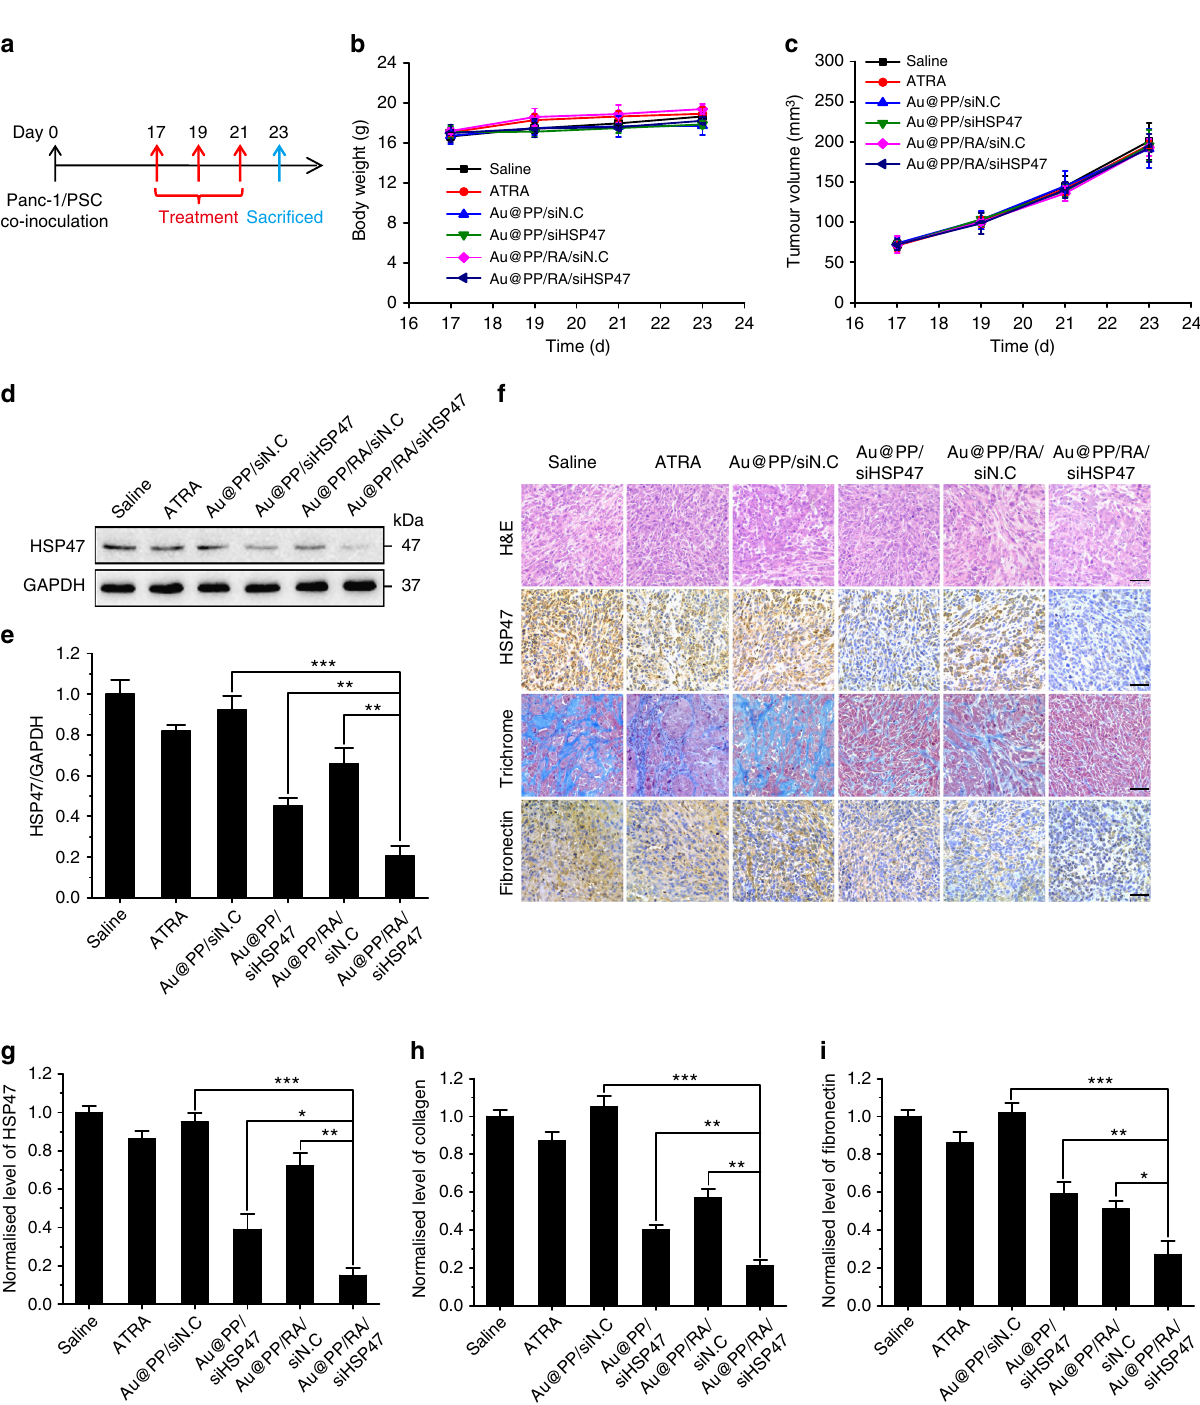
Fig. 7 Stroma modulation in Panc-1/PSC subcutaneous xenografts. a Scheme of different treatment formulations for stroma modulation. The desmoplastic pancreatic subcutaneous xenografts were established by co-inoculation of Panc-1 and PSCs in BALB/c nude mice. Various formulations (ATRA: 2.4 mg/kg; siRNA: 0.97 mg/kg) were given intravenously every 2 days for three injections. b Body weight changes of mice during treatment. c Tumour growth curves during treatment. d Western blot analysis of HSP47 protein in tumours. e Quantitative analysis of the normalised HSP47 protein expression in tumours (using Image J software). f Histological studies with H&E, trichrome staining of collagen and immunohistochemical staining of HSP47 and fi bronectin in tumour sections. Scale bars, 50 μ m. g – i Quantitative analysis of the normalised HSP47 ( g ), collagen ( h ) and fi bronectin ( i ) protein levels (using Image J software). The data are shown as the mean ± s.d. ( n = 3). * p < 0.05, ** p < 0.01, *** p < 0.001 (Student ’ s t